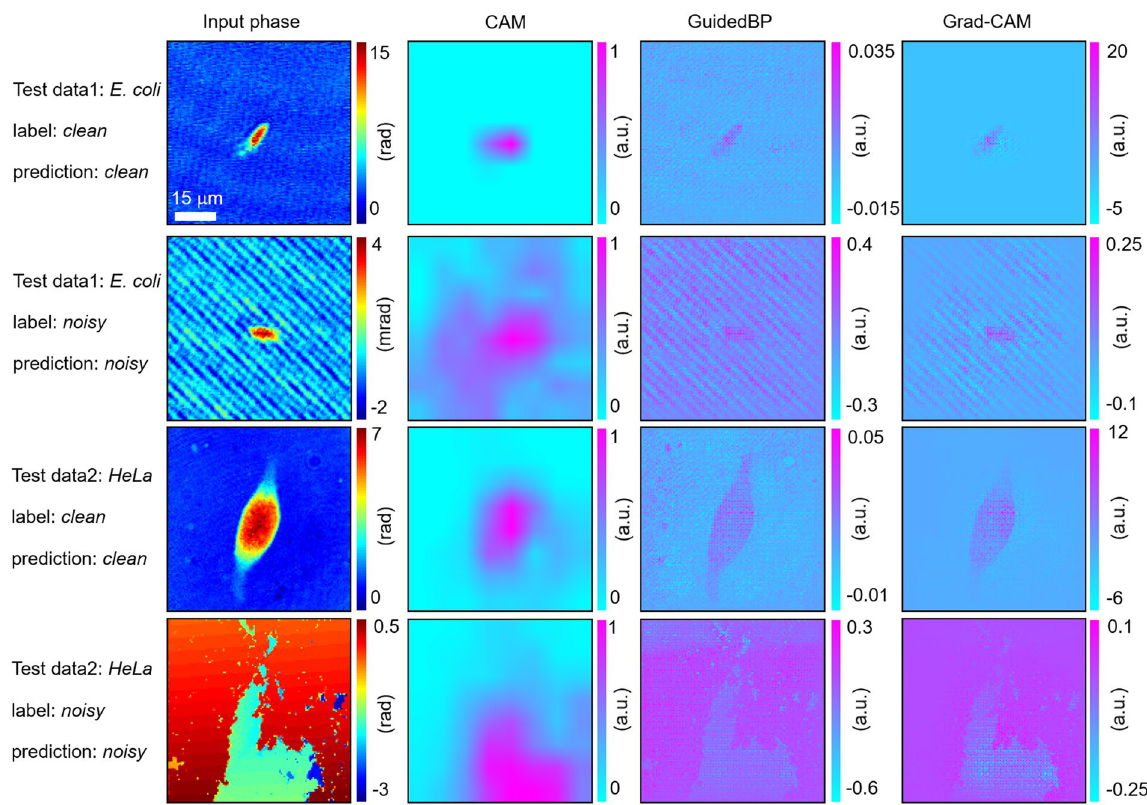
three widely used visualisation techniques (see Methods). For the four types of image (clean/noisy E . coli and clean/noisy NIH3T3), the input phase image, corresponding class activation mapping (CAM) images, guided back-propagation (GuidedBP) images, and gradient-weighted class activation mapping (Grad-CAM) images are depicted in Fig. 6 (columns 1 − 4). The CAM images do not display the details of the interesting objects (i.e., E . coli , NIH3T3), but distinguish the objects from the background. Unlike the CAM images, the BP images provide a global distribution of the activations with a higher resolution; however, the information around the specimens is less localised. Finally, the Grad-CAM images, inferred as clean (rows 1 and 3), elucidate a more localised detection of the target specimen, while parasitic fringe patterns and broken phases, dispersed across the images, are visible